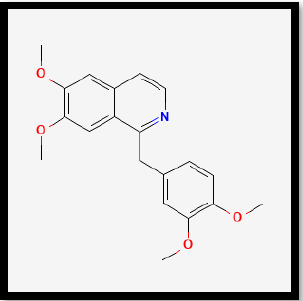
Figure 7. Chemical structures of caffeine.